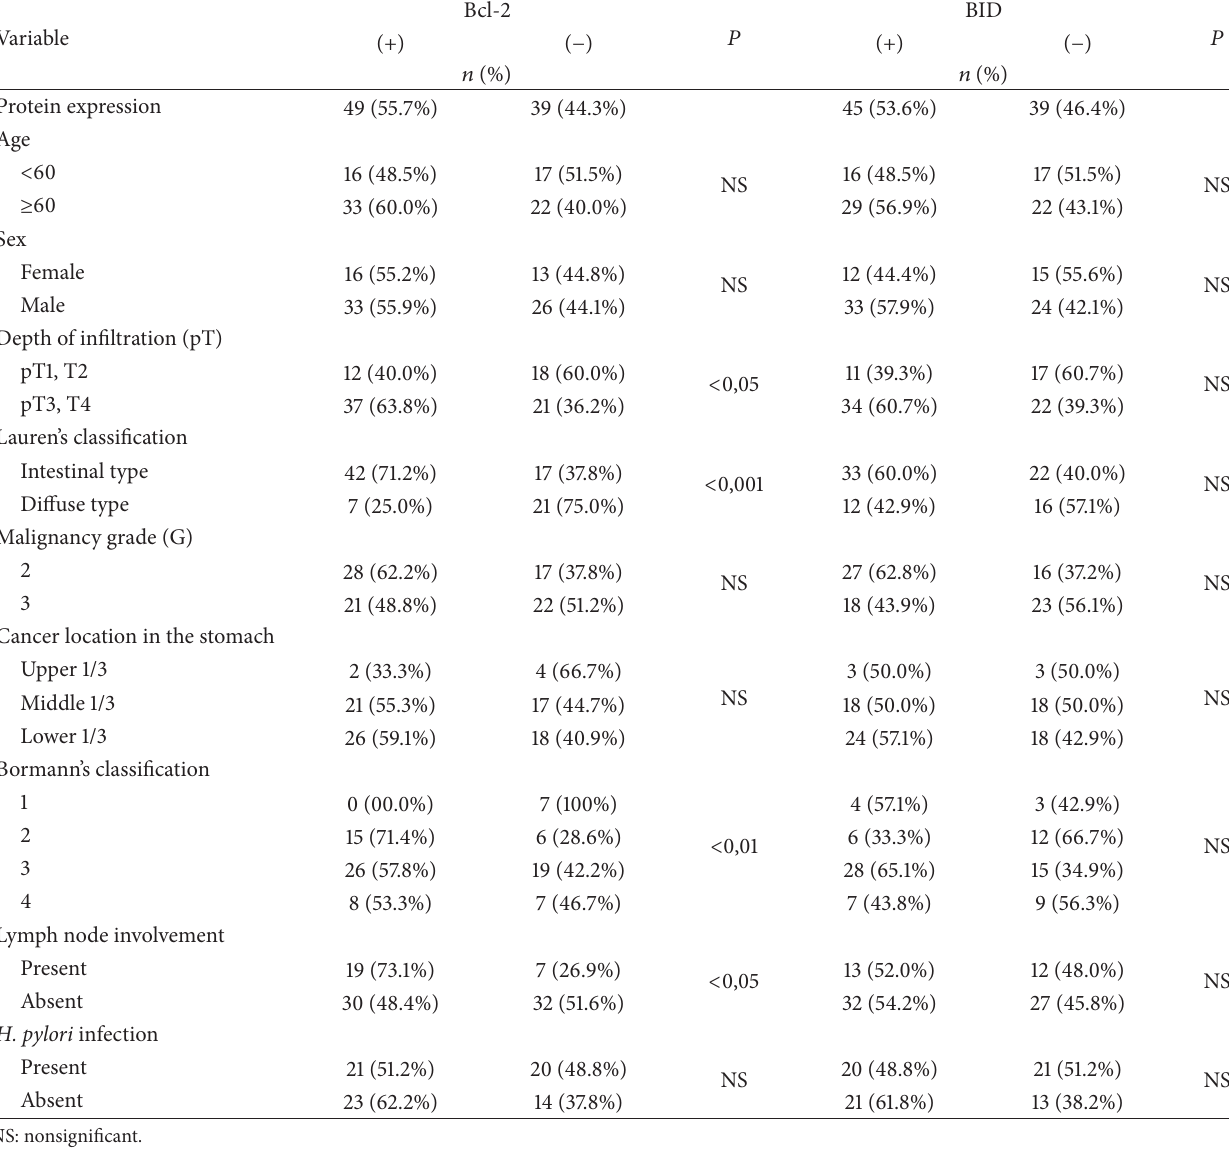
Table 1: Bcl-2 and BID expression in gastric cancer cells depending on clinicopathological factors and Helicobacter pylori infection.